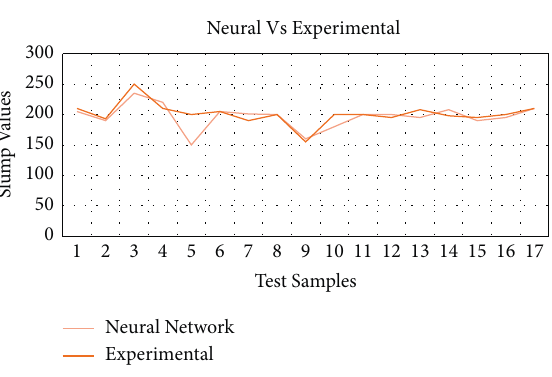
Figure 9: Neural vs.